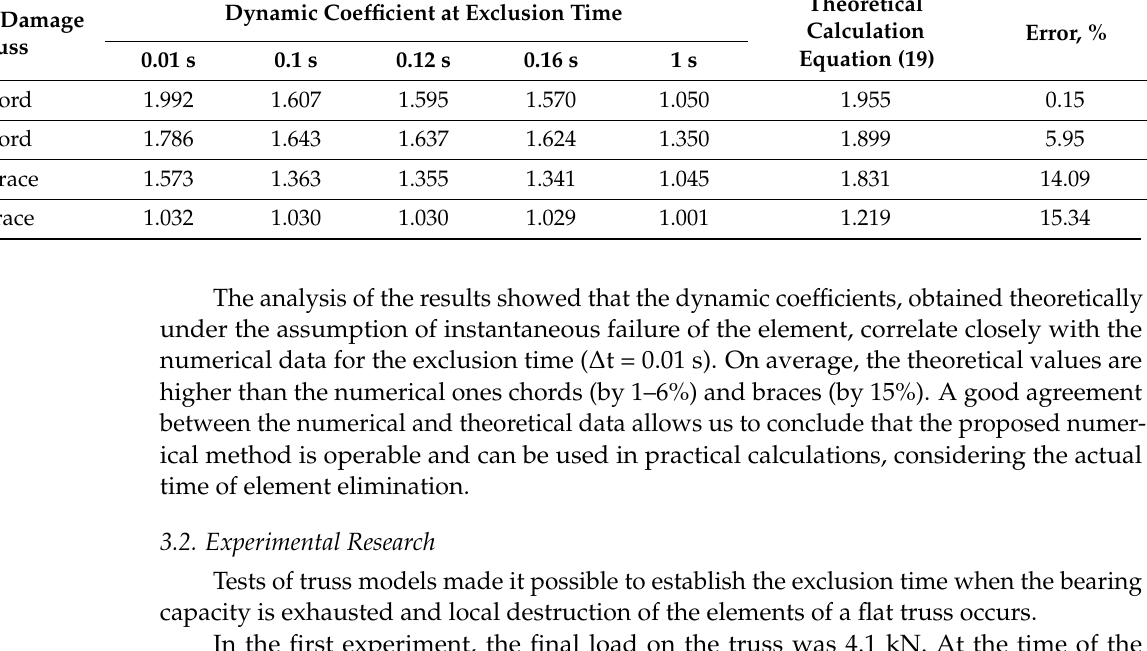
Figure 16. Truss with a damaged middle brace.